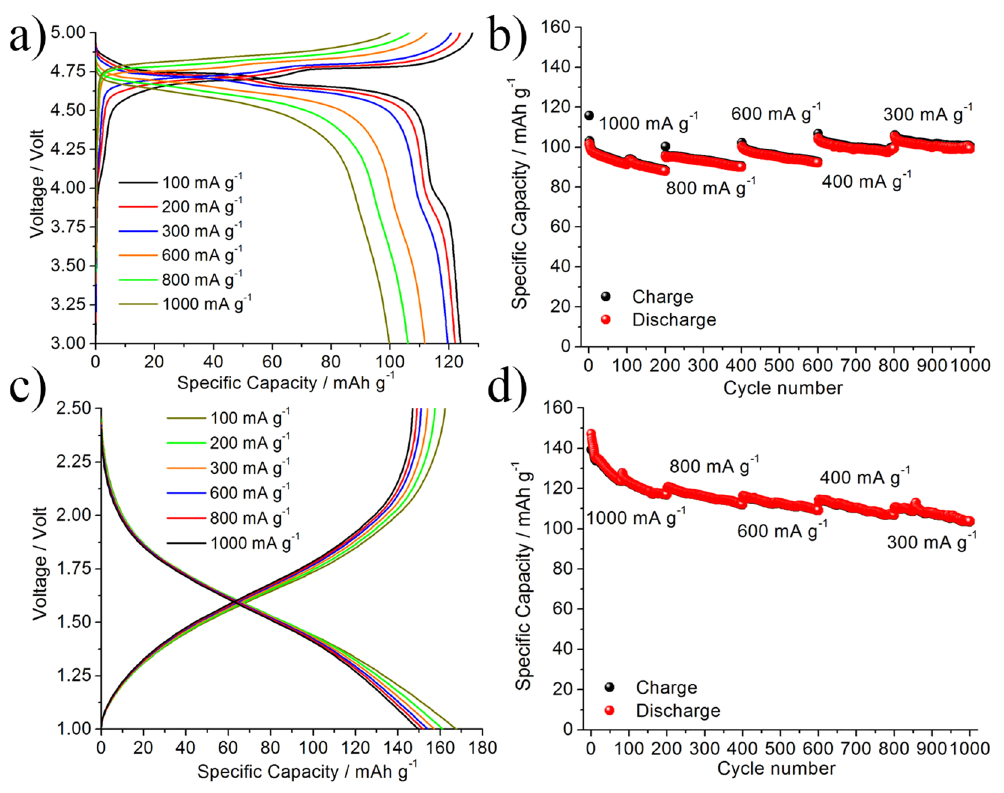
Figure 2. ( a ) Voltage profiles and ( b ) specific capacity performance of the Li/LP30/LNMO half-cell at different current rates. ( c ) Voltage profiles and ( d ) specific capacity performance of the Li/LP30/TiO 2 -B half-cell at different current